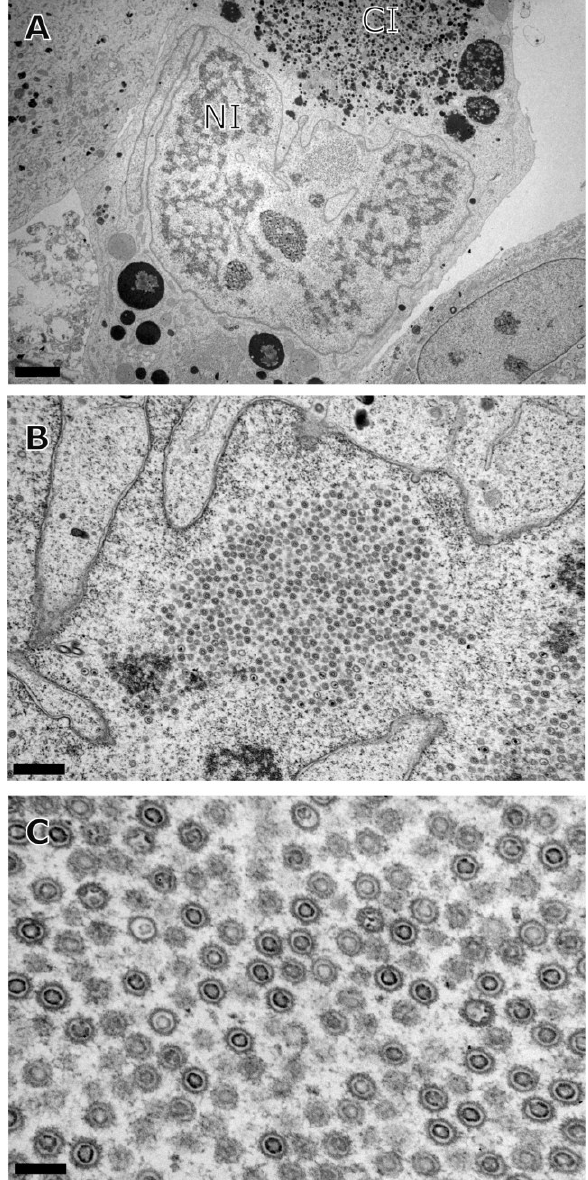
Figure 3. Transmission electron micrograph of HF cells infected with HCMV (Towne) in the presence of BDCRB and fixed for processing at 7 days post infection ( A ) A single infected cell showing nuclear inclusion (NI) as well as cytoplasmic inclusion (CI); ( B ) A part of the nucleus demonstrating excessive accumulation of B-capsids in the center of the micrograph; ( C ) A higher magnification image of the mostly B-capsids accumulating in the nucleus. Scale: 4 µm ( A ), 1 µm ( B ), 0.4 µm ( C